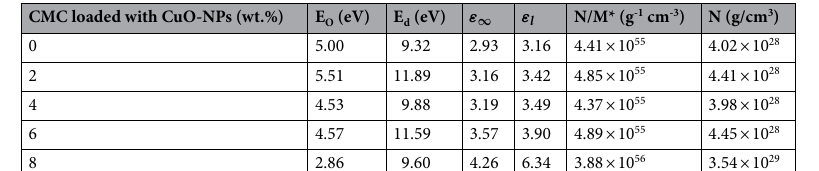
CMC loaded with CuO-NPs (wt.%)